Question: Provide a one-line summary of what is displayed.
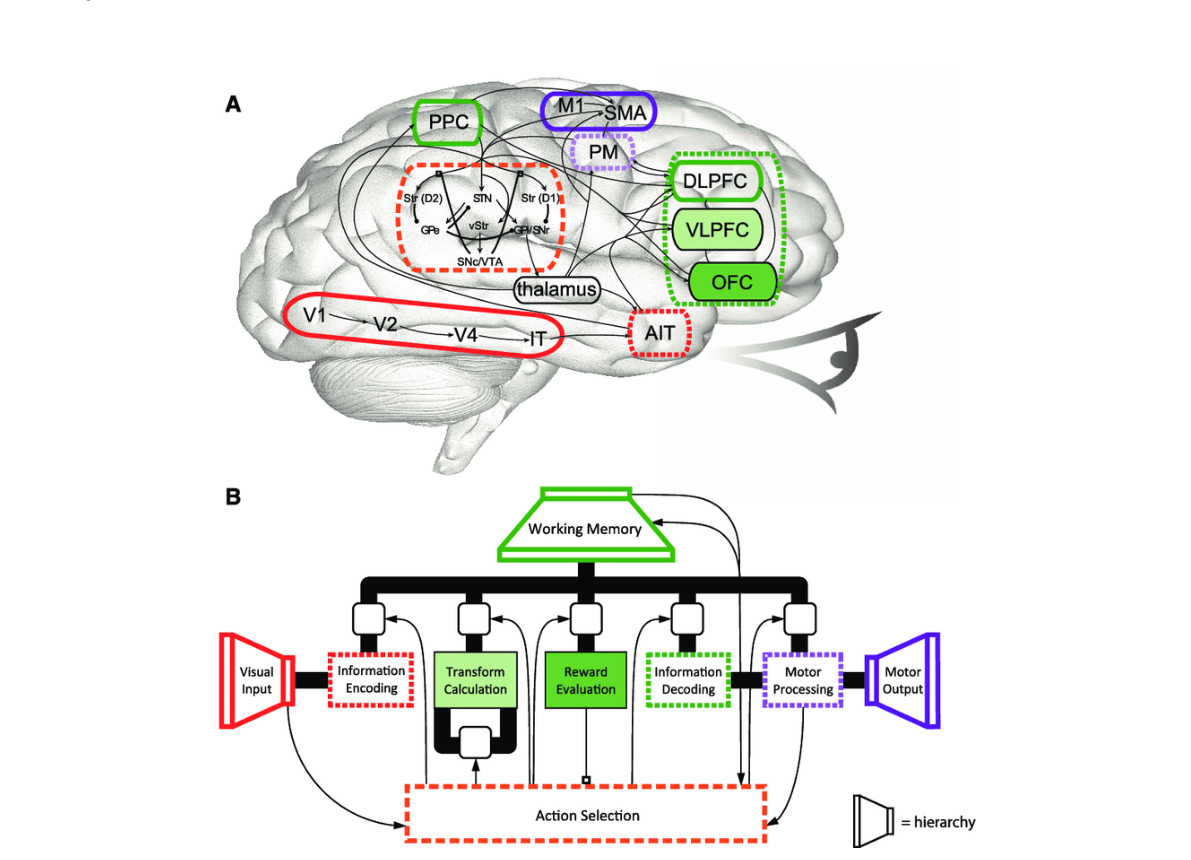
Answer: This illustration represents a large-scale 3D brain model, inspired by Spaun.(a) It highlights the main brain structures of Spaun and their connections. (b) It depicts communication pathways within Spaun’s brain: thick black lines represent connections within the cortex, while thin lines show connections between the Basal Ganglia and the cortex. Image source: [24]